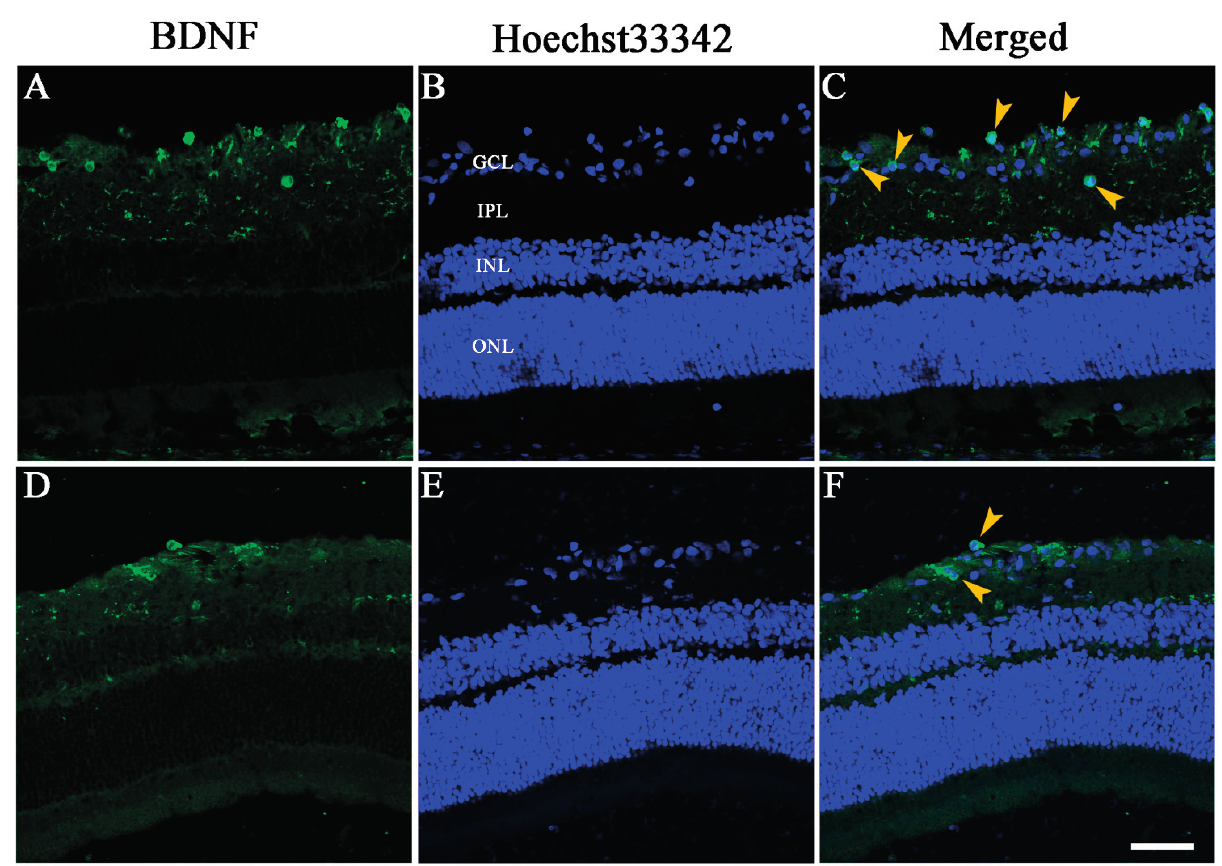
respectively. In this study, the percentages of surviving RGC densities in Control groups reduced to 52% and 12% at day 7 and 14 day time points, similar to those reported previously [19]. Figure 6. Immunoreactivity of BDNF in radial sections of the rat retina 7 days after ON transection. Stronger BDNF immunohistochemical staining (green) can be found in the GCL and IPL in 60 mg/kg·bw LiCl group ( A ), compared with Control group ( D , n = 6 for each group). The nuclei of cells were stained with Hoechst33342 (blue, B , E ). The arrow heads show BDNF-immunoreactive RGCs in the RGC layer (GCL) in both the LiCl group ( C ) and the Control group ( F ). Scale bar = 50 μ